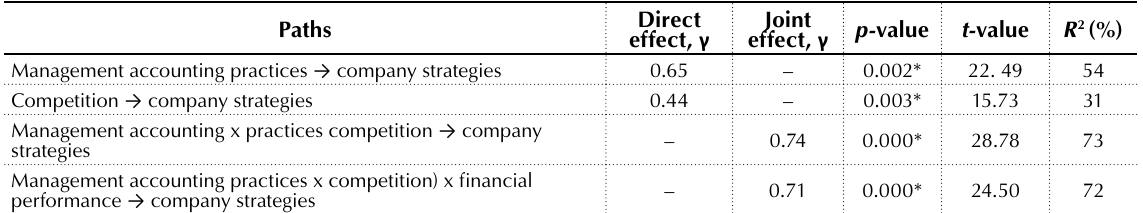
Direct Joint p- value t- effect, γ effect, γ